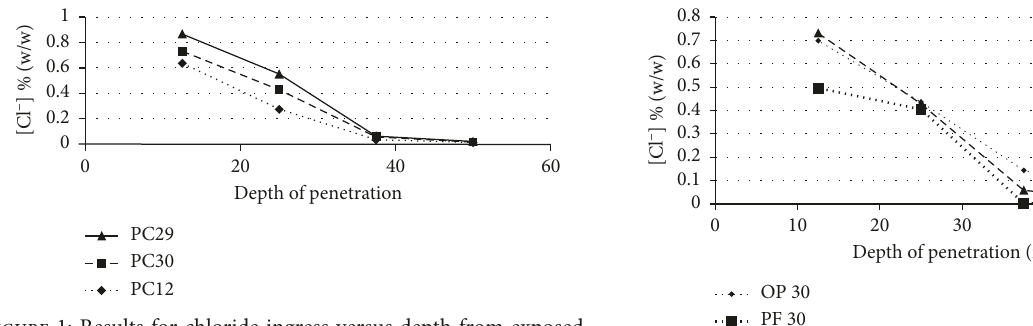
Figure 1: Results for chloride ingress versus depth from exposed surface for PCDC.